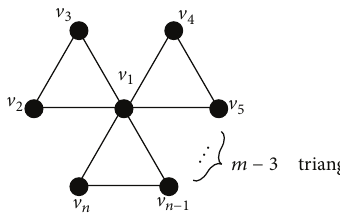
Figure 2: The star 𝑆 3 𝑚 on 𝑚